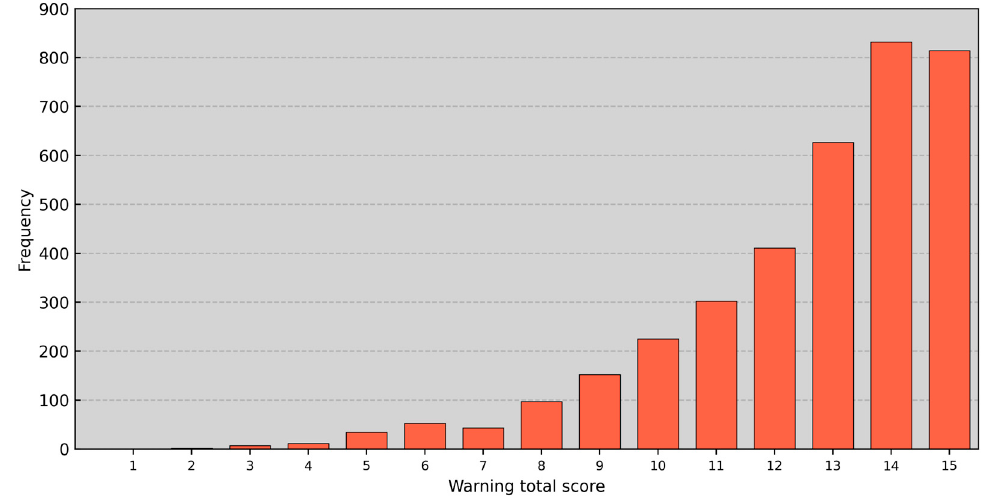
Figure 8. Frequency of 2020 RFW total scores for all states.